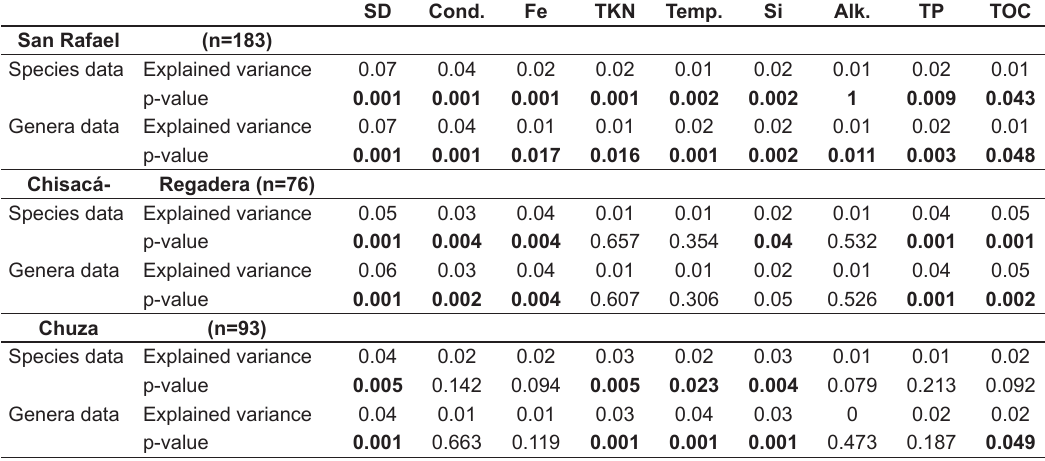
The variance of each variable corresponds to the conditional effects. SD: Secchi Disk; Cond.: conductivity; Temp.: temperature; Alk.: